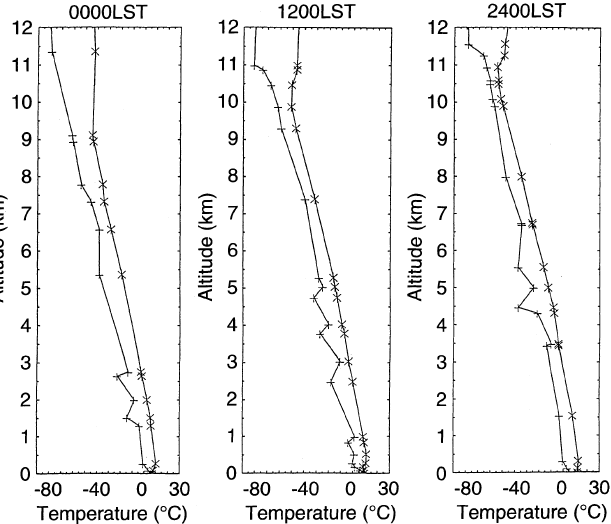
Fig. 2. Temperature and dew point temperature profiles introduced in the model for July 12, 1991 (from 0000 LST to 2400 LST). The stars correspond to the values measured by the